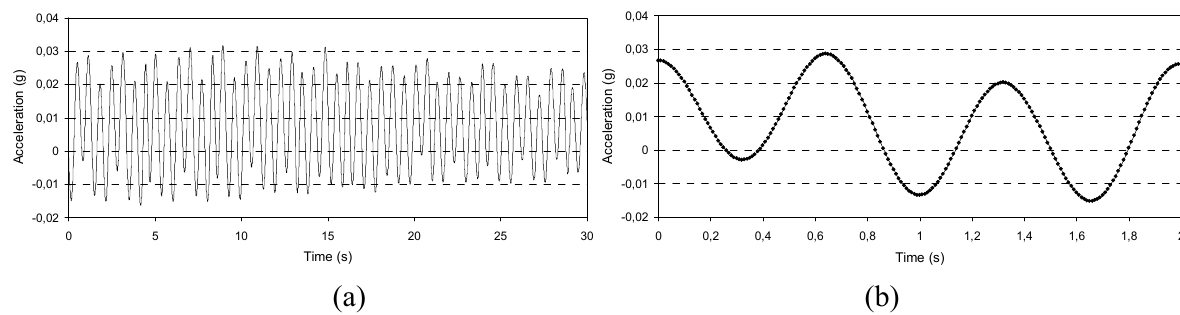
Figure 11. Low frequency characterization after dynamic excitation: 0.02 g amplitude, 1.5 Hz frequency, z-axis; whole acquisition (a) and detail of the wave form (b).